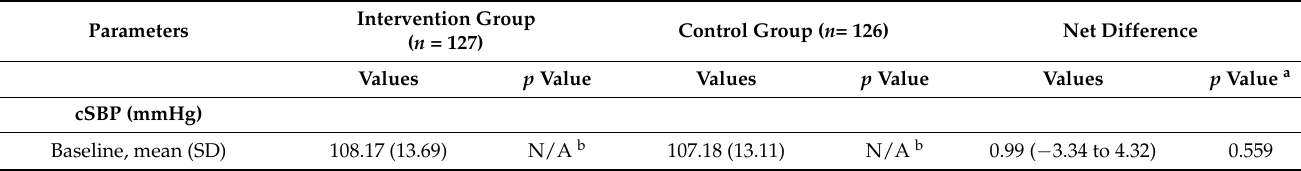
Table 3. Effect of the mobile health intervention on pulsatile